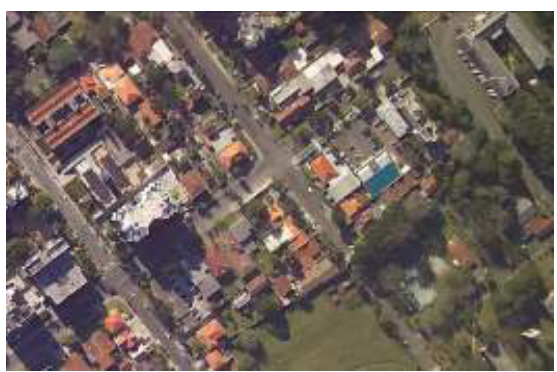
Figure 1. RGB aerial